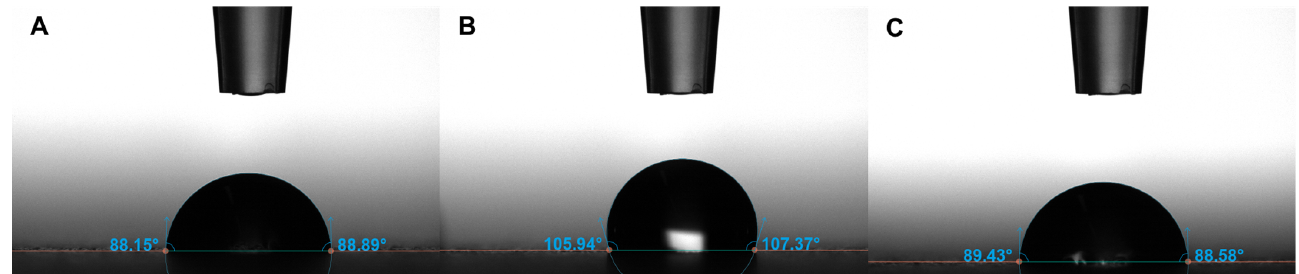
Figure 5. ( A – C ) Water contact angle measurements of surfaces.